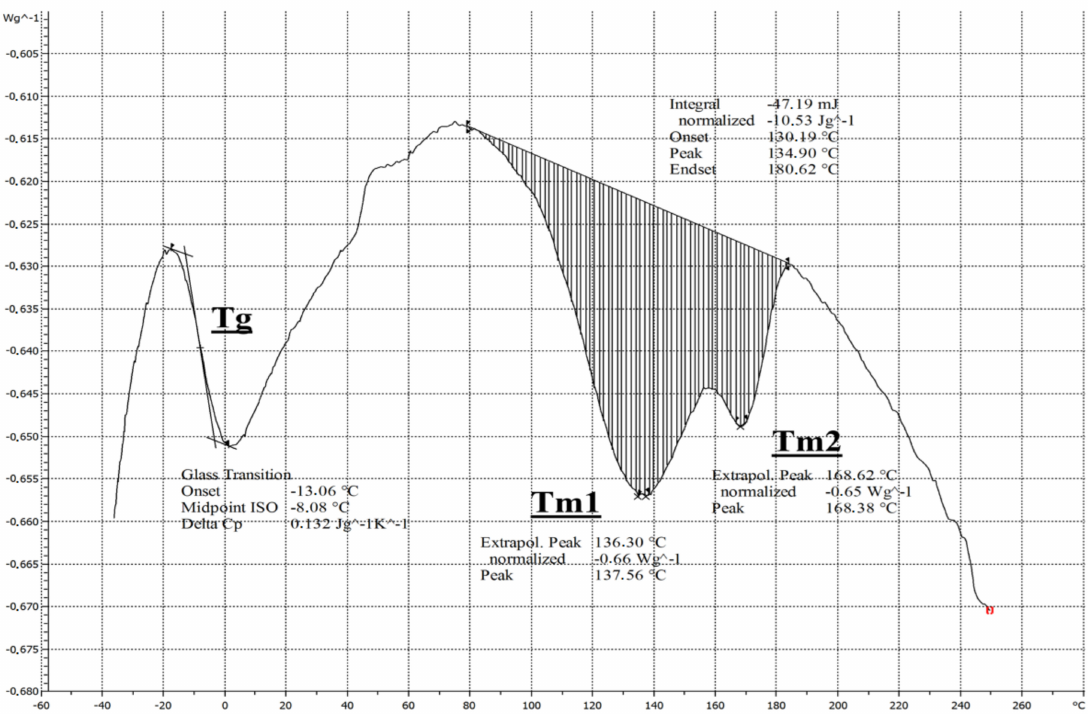
Figure 4. Di ff erential scanning calorimetry (DSC) of a non-woven polyurethane